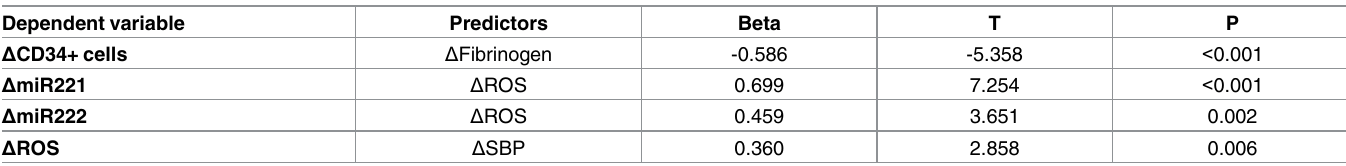
Table 4. Multiple regression